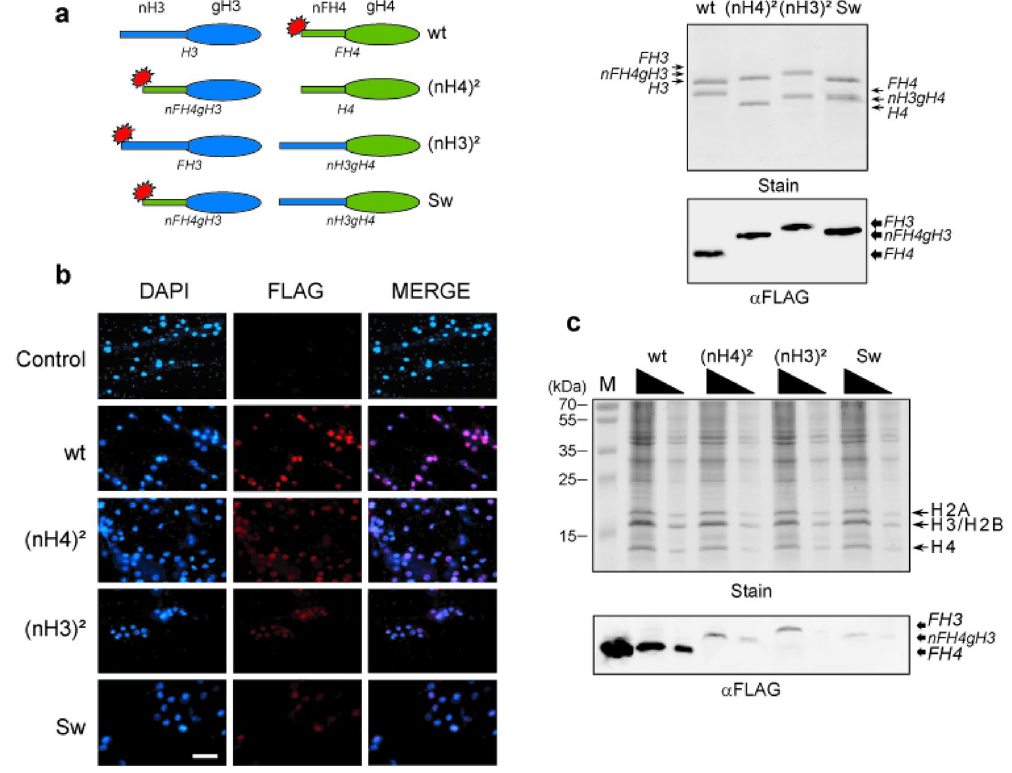
Figure 2. Function of the H3/H4 amino-tail domains in nuclear import in the S-phase. ( a ) Nomenclature and preparation of the exogenous histone complexes. The right panel is a diagram of the different histones used to form the different complexes. The regions in blue correspond to H3 domains, in green to H4 domains, and the red stars represent the FLAG-tag epitope. The complex wt corresponds to H3/FH4, (nH4)² to nH4gH3/FH4 (duplicate of the H4 tail), (nH3)² to FH3/nH3gH4 (duplicate of the H3 tail), and Sw to nFH4gH3/nH3gH4 (swapping of the two tail domains), respectively (the histone sequences are indicated in supplementary information). The right panel shows the SDS-PAGE (Stain) and the Western blot ( α FLAG) of the complexes wt, (nH4)², (nH3)² and sw, respectively. ( b ) Microscopic observations of the different H3/H4 complexes. Following incorporation of exogenous complexes, cell fragments were squashed, fixed, and stained with anti-FLAG antibody (FLAG) and counterstained with DAPI (DAPI). The bar corresponds to 20 μ m. ( c ) Nuclear import of H3/H4 complexes. Physarum fragments were treated during the S-phase with exogenous histone complexes: wt ( H3/FH4 ), (nH4)² ( nFH4gH3/H4 ), (nH3)² ( FH3/nH3gH4) and Sw ( nFH4gH3/nH3gH4) , respectively. Nuclei were then isolated and analyzed by SDS-PAGE (Stain) and Western blotting ( α FLAG). Lane M corresponds